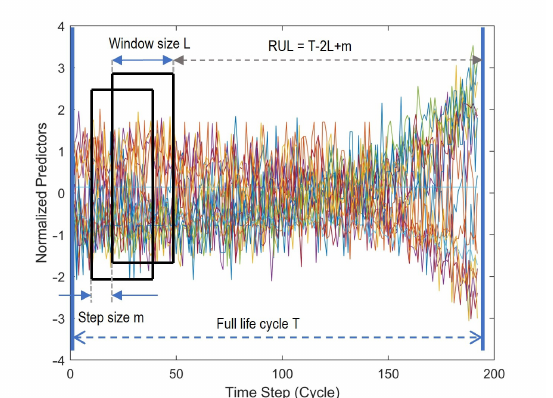
Figure 8. Moving window strategy over sensor measurements of an